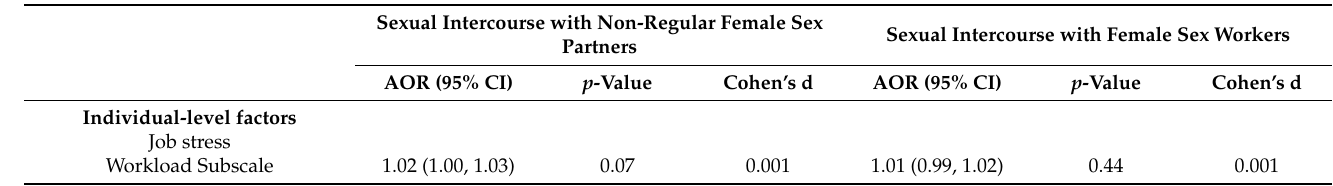
Table 4. Factors associated with sexual intercourse with non-regular female sex partners and female sex workers in the past 6 months ( n =